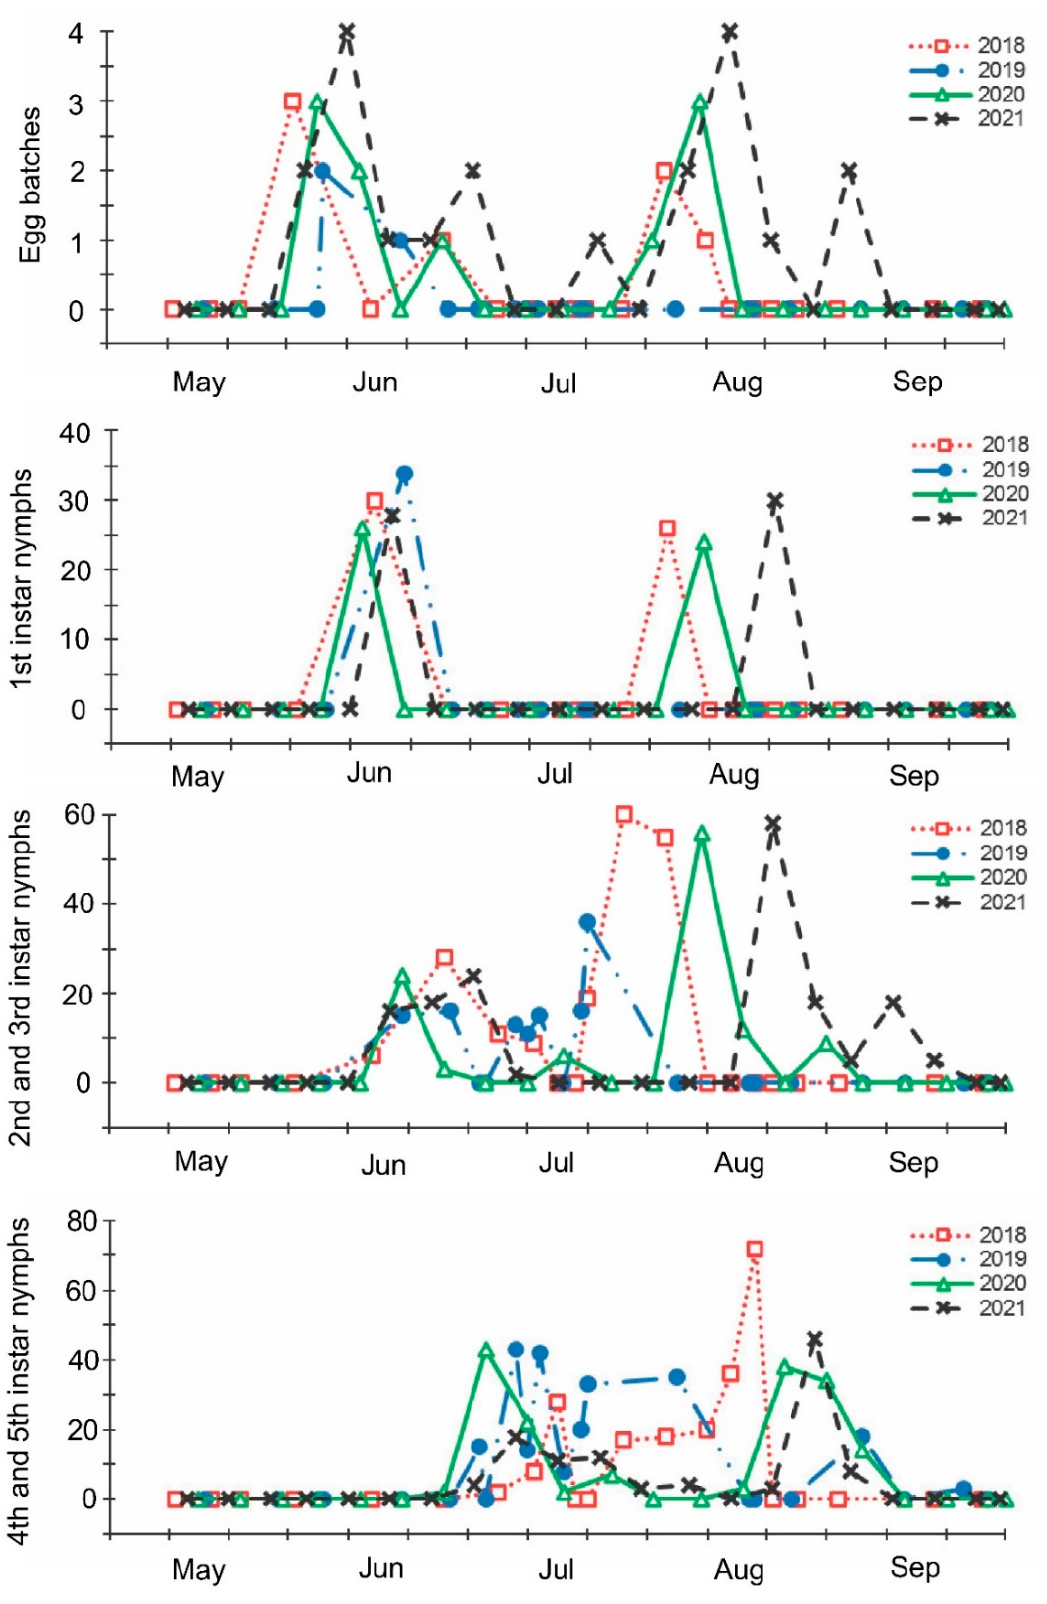
Figure 2. Seasonal changes in numbers of Halyomorpha halys egg batches and nymphs of different instars per sample during 2018–2021. Each symbol corresponds to one